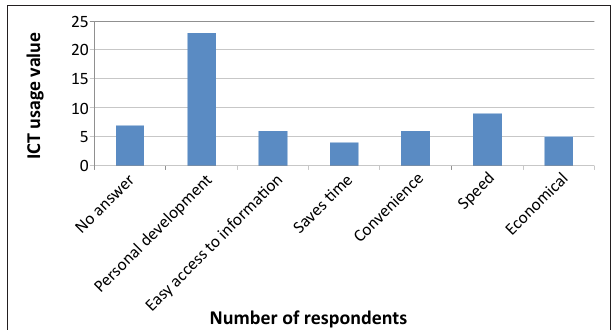
FIGURE 2: Value added by the use of information and communication technology (ICTs).